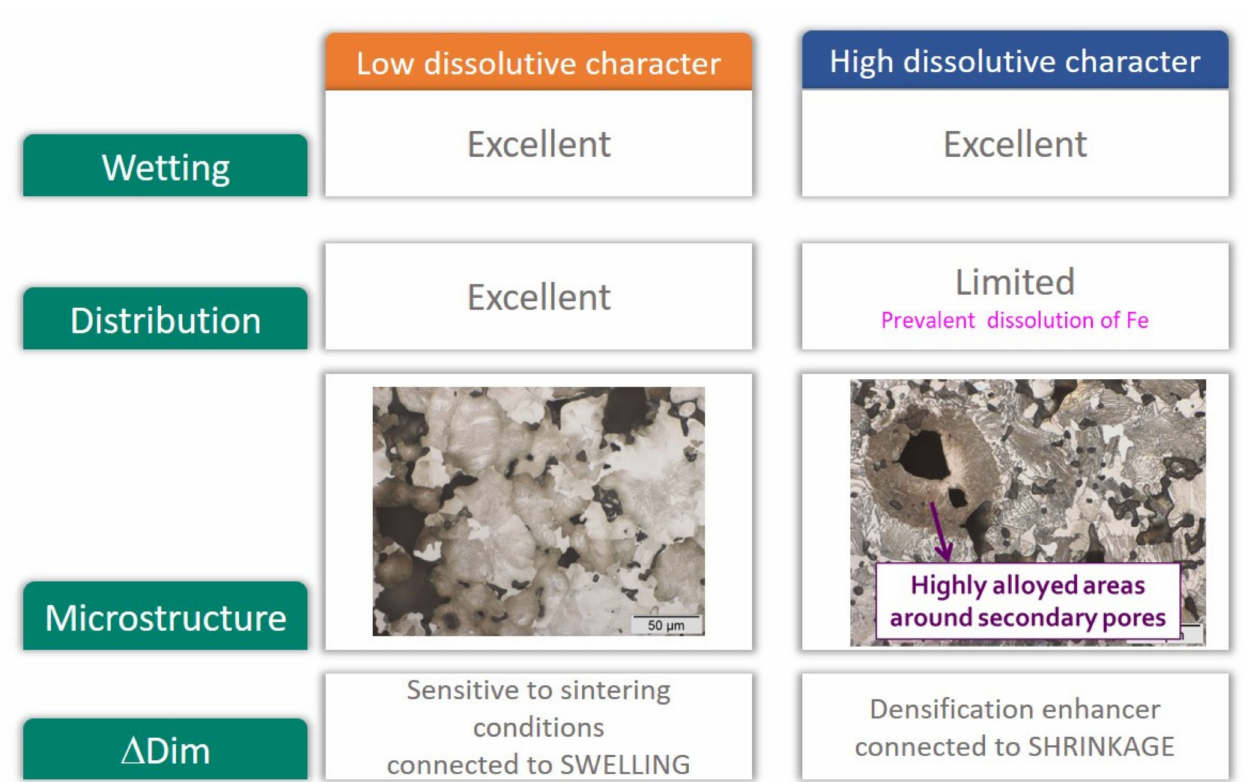
Figure 13. Properties map according to the nature of the dissolution